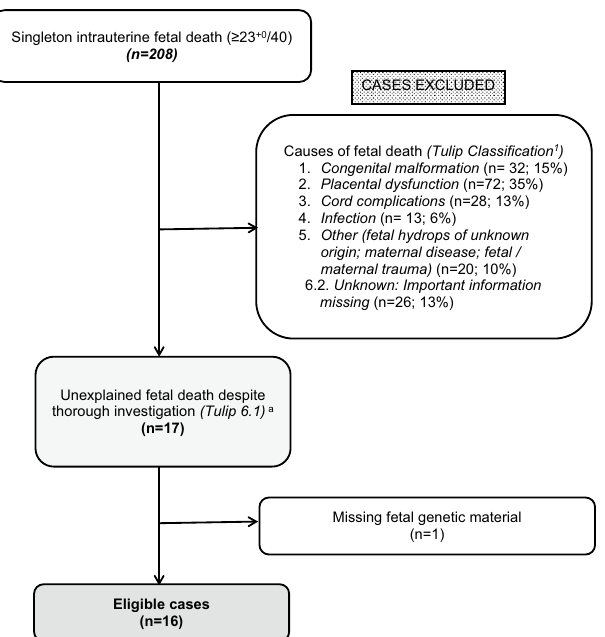
Figure 1. Flowchart showing selection process of cases between January 2003 and December 2017. Superscript a: Investigation includes fetal post-mortem examinations (fetal autopsy; post-mortem magnetic